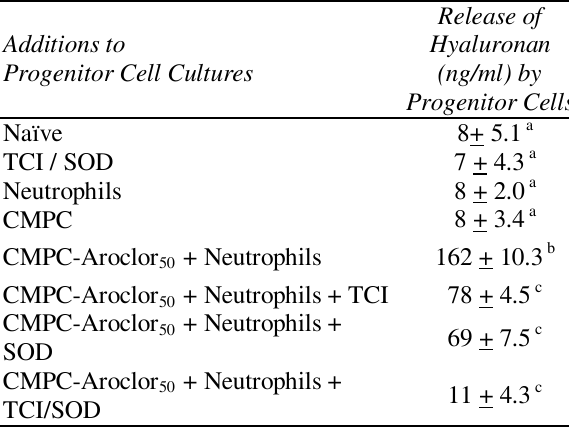
Table 8: Protease Inhibitor and Super Oxide Dismutase Affords Protection against Neutrophil-Dependant PC Toxicity . Trypsin-chymotrypsin inhibitor (50 µg/well) and superoxide dismutase were added to neutrophil/PC co- cultures (2 X 10 6 /5 x 10 6 cells/mL, respectively) treated with or vehicle. Co-cultures were CMPC-Aroclor (6, 12, 25 or 50 µM) then incubated for 24 hrs. After this incubation, the content of hyaluronan in culture mediuM was analyzed as a marker = conditioned mediuM of PC toxicity. CMPC-Aroclor (X) from PC treated with Aroclor, where (X) is the concentration of Aroclor; TCI = trypsin-chymotrypsin inhibitor; SOD = superoxide dismutase; Values represent mean + S.E.M.; a, b, c indicate values that are significantly different